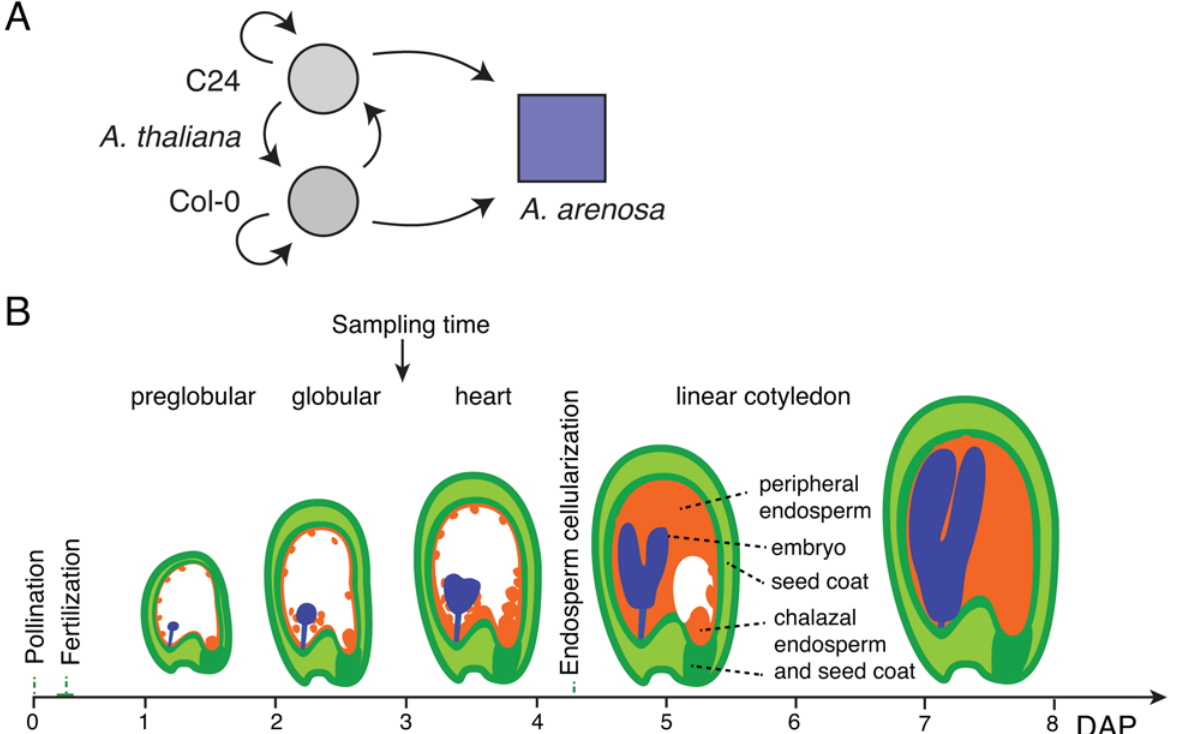
Fig 1. Hybrid crossing scheme and RNA sampling. A . Crosses between A . thaliana accessions, A . thaliana by A . arenosa interspecific crosses, and selfed crosses of parents were performed to detect parentally biased gene expression at 3 days after pollination. Arrows point to the males. B . Diagram of early A . thaliana development displaying seed compartment and stage of RNA